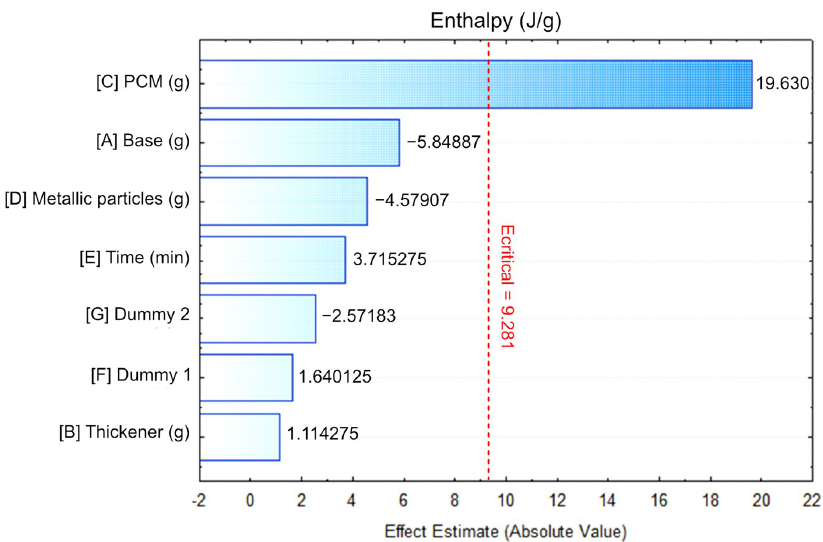
Figure 6. Pareto diagram of the Plackett–Burman experiment .